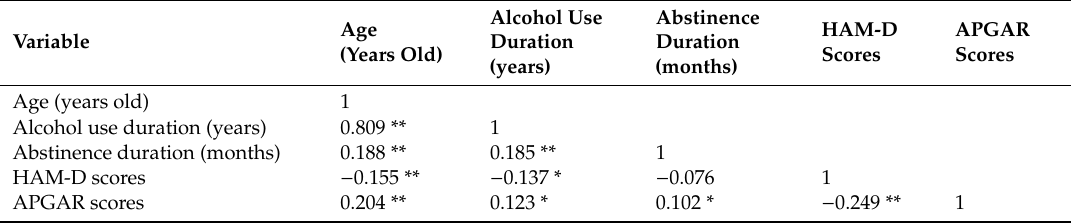
Table 2. Spearman’s correlations for psychosocial functioning and alcohol use (n =